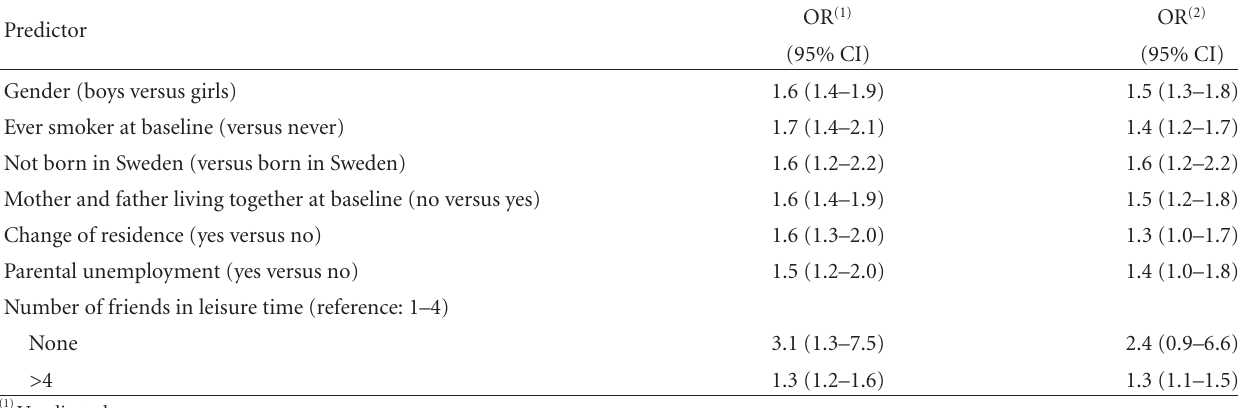
Table 4: Odds ratios of nonparticipation according to behavioural psychosocial characteristics at baseline.